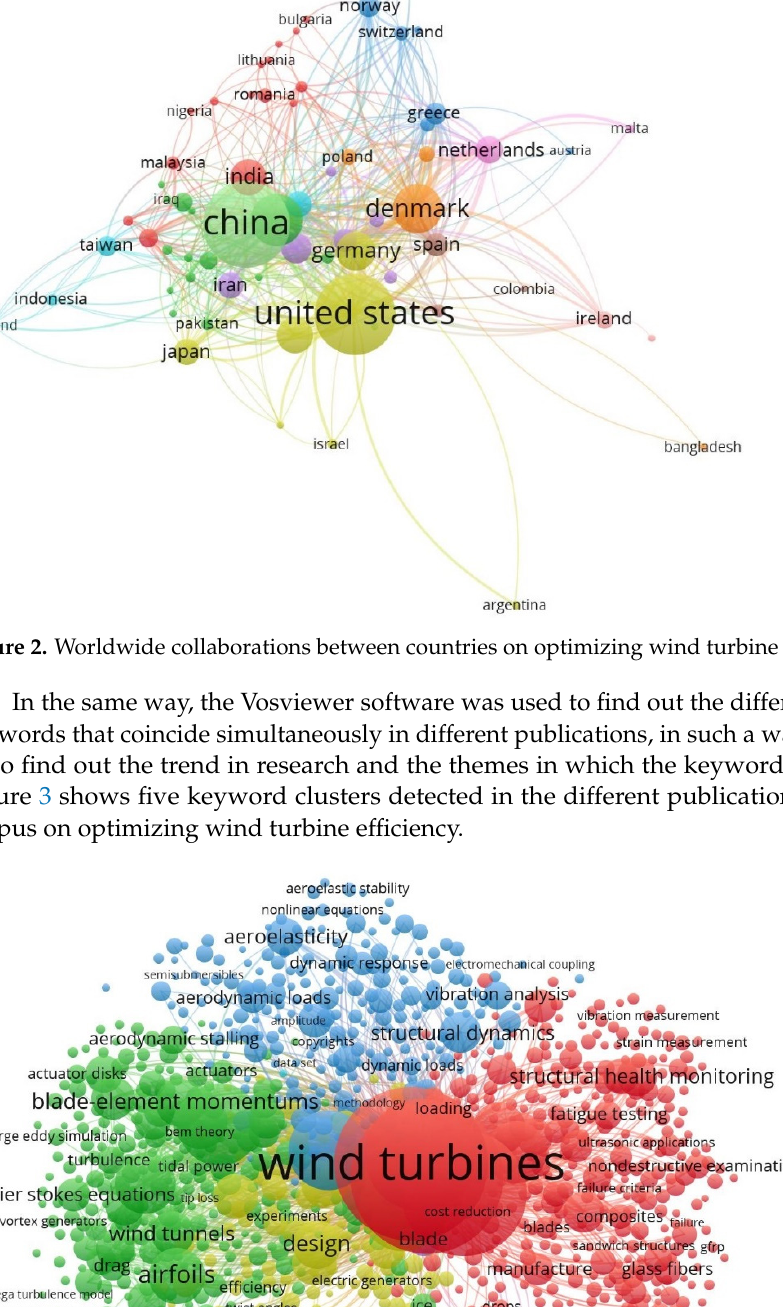
Figure 3. Keyword clusters on optimizing wind turbine efficiency.